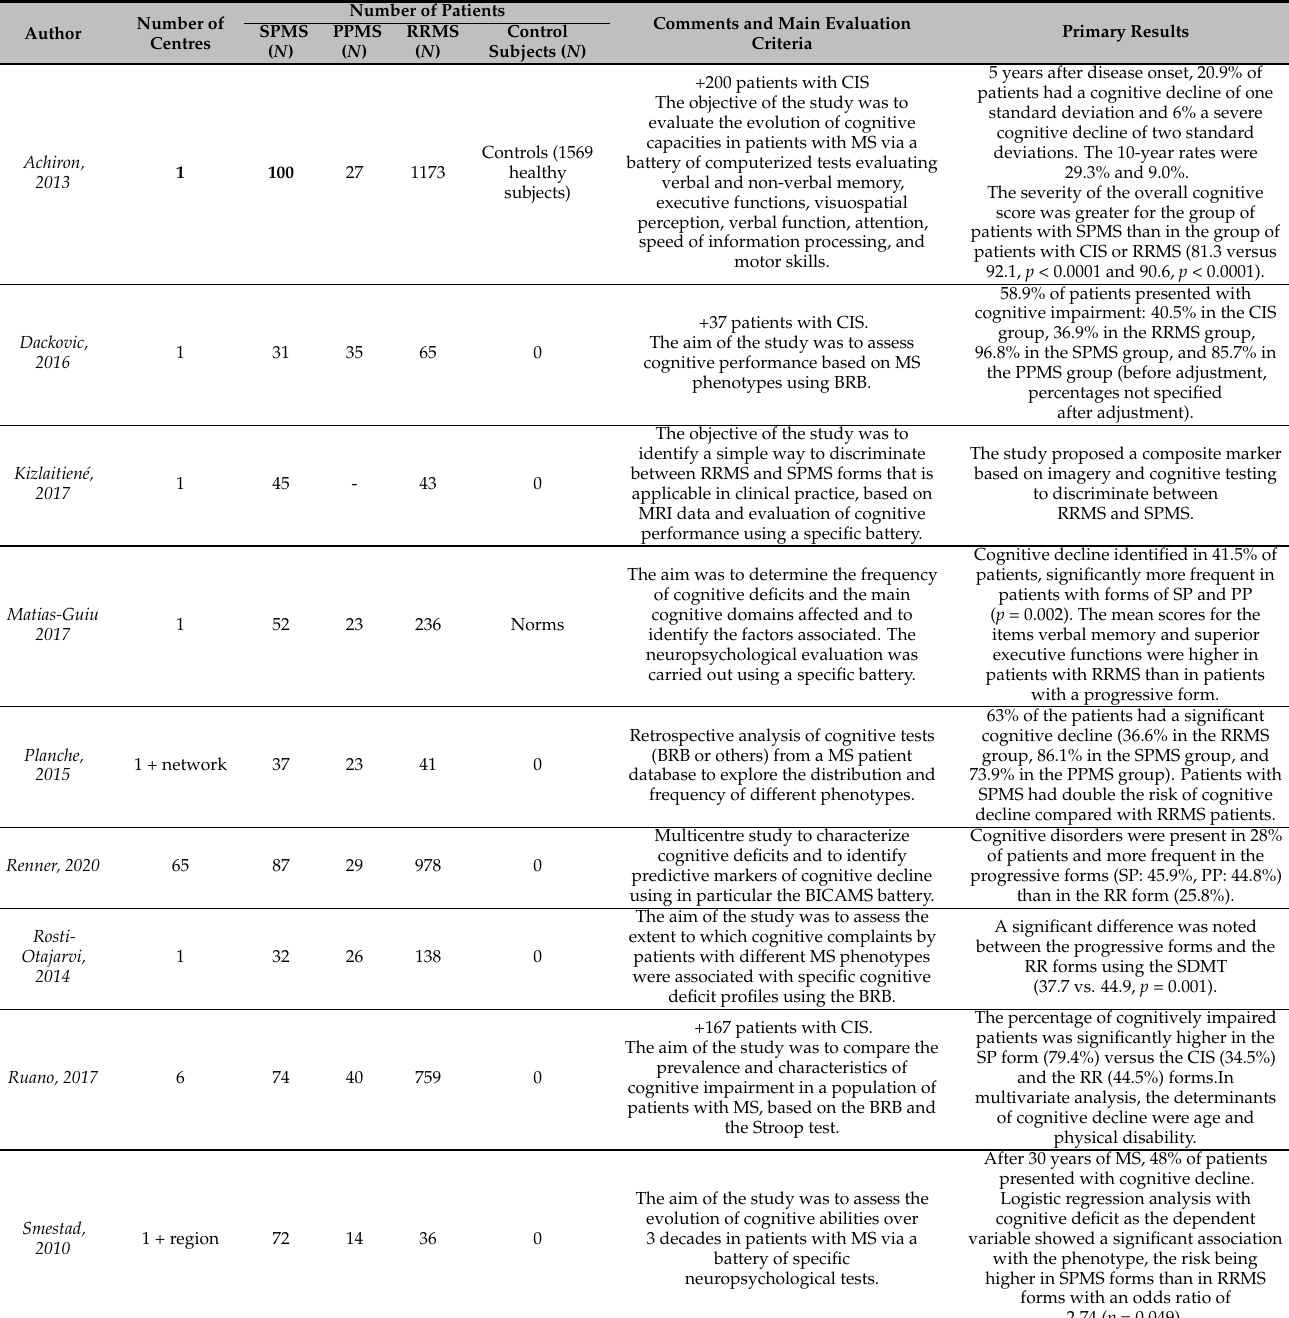
Table 2. Other studies about cognition in secondary progressive multiple